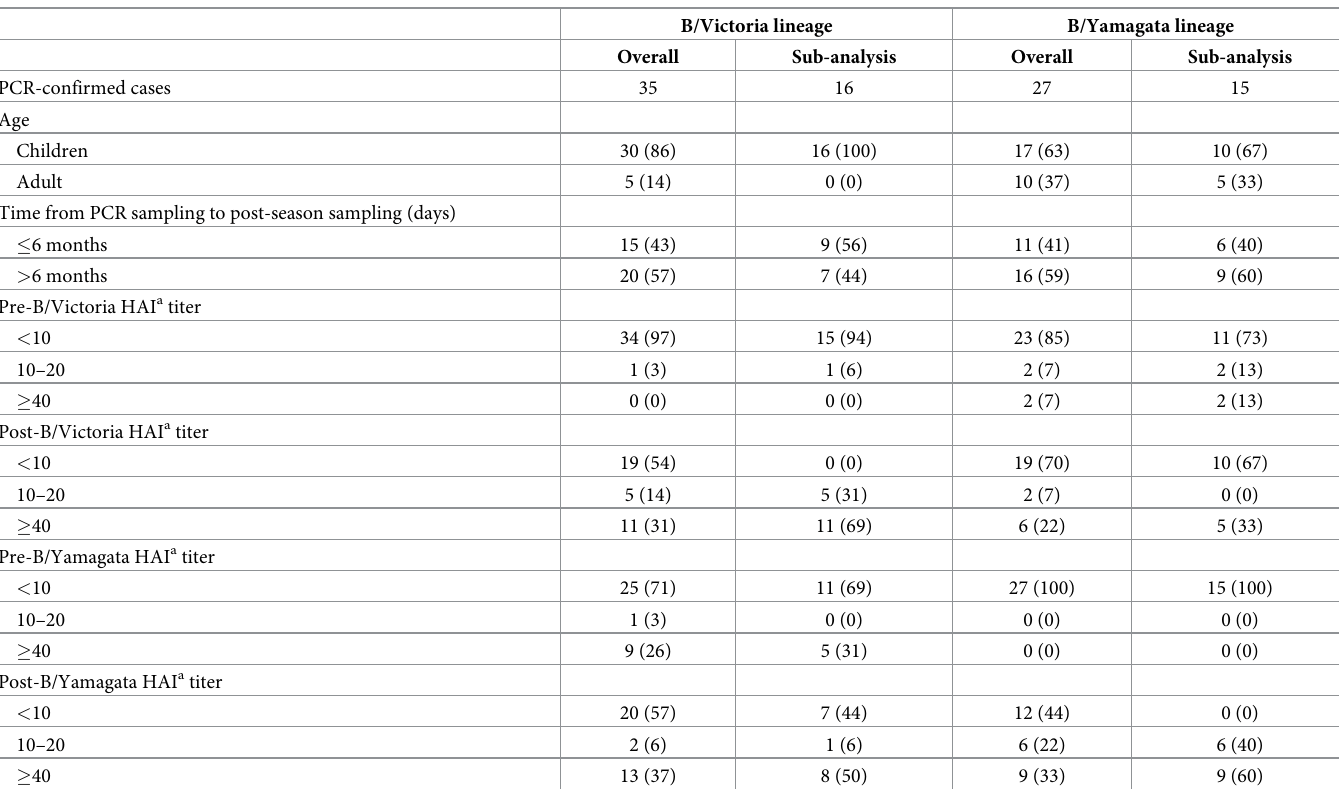
Table 2. Characteristics of the PCR-confirmed cases.